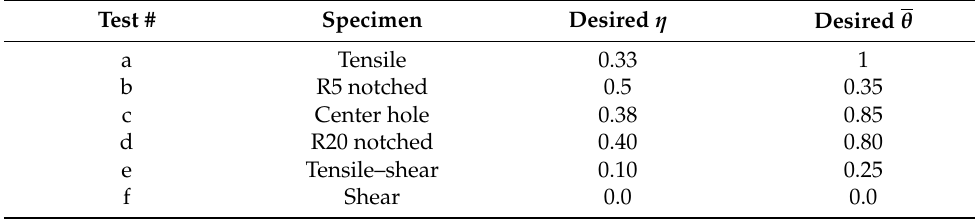
Table 1. Experimental conditions for designed specimens.